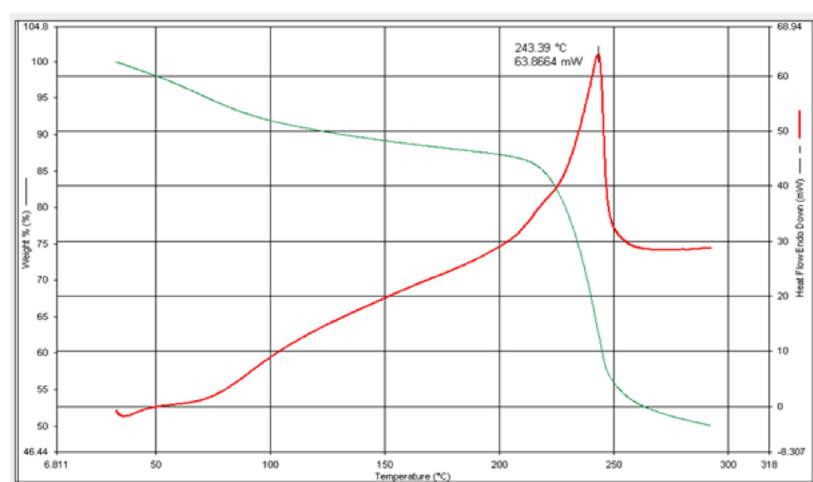
FIGURE 8 (b) - Differential Scanning calorimetric analysis of sodium alginate alone.